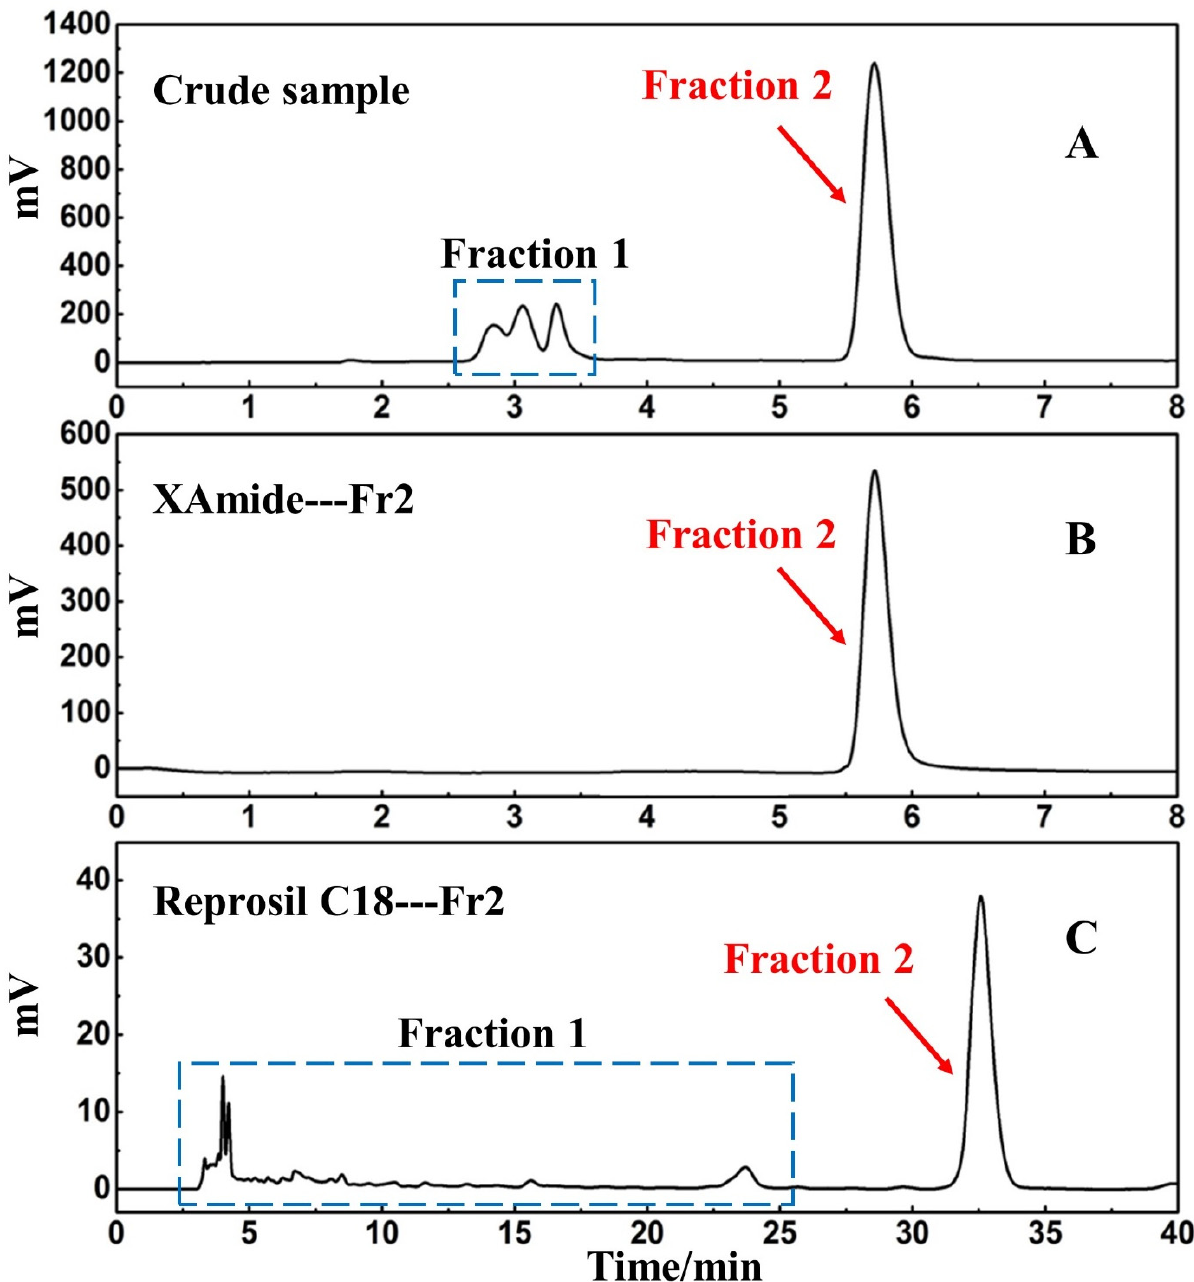
Figure 3. HPLC analysis of the target fraction on XAmide (( A ): crude sample; ( B ): Fraction 2) and ReproSil C18 (( C ): Fraction 2) analytical column; injection volume: 1.0 μ L. Conditions of XAmide analytical column: isocratic elution: 0–16 min, 100% dichloromethane; monitoring wavelength: 270 nm; flow rate: 1.0 mL/min; column temperature: 30 °C. Conditions of ReproSil C18 analytical column: isocratic elution: 0–40 min, 100% methanol; monitoring wavelength: 270 nm; flow rate: 1.0 mL/min; column temperature: 30 °C.